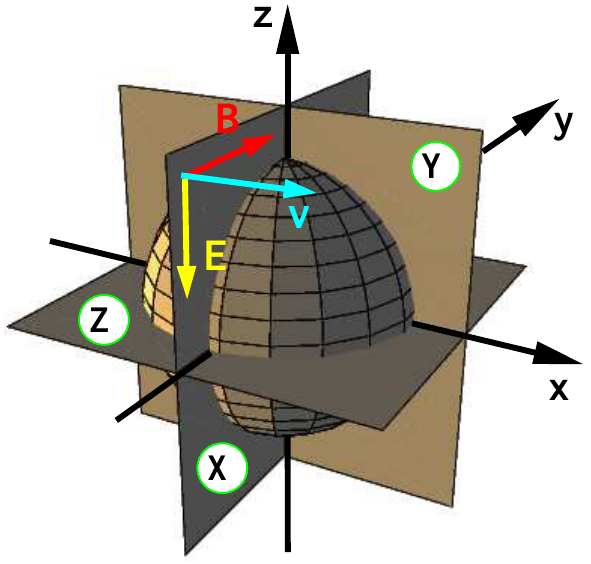
Fig.1. Plasmaenvironment ofMars–Simulation geometry. Theundisturbed plasmaflowisdirected alongthe (+ x ) axis, whereas thehomogeneous solar Fig. 1. Plasma environment of Mars – Simulation geometry. The windmagneticfieldisparalleltothe (+ y ) axis. Hence,theconvectiveelectricfield,definingthedirectionofasymmetry,isorientedantiparalleltothe z axis. Theobstacle’sdaysideislocatedinthe ( x< 0) hemisphere. Inthefigure,thecuttingplanes ( x =0) , ( y =0) and ( z =0) aredenotedbytheabbreviations undisturbed plasma flow is directed along the (+x)-axis, whereas the X , Y and Z ,respectively. homogeneous solar wind magnetic field is parallel to the (+y)-axis. Hence, the convective electric field, defining the direction of asym- metry, is oriented antiparallel to the z-axis. The obstacle’s dayside is located in the (x< 0 ) hemisphere. In the figure, the cutting planes (x = 0 ) , (y 0 ) and (z 0 ) are denoted by the abbreviations X, Y and Z,